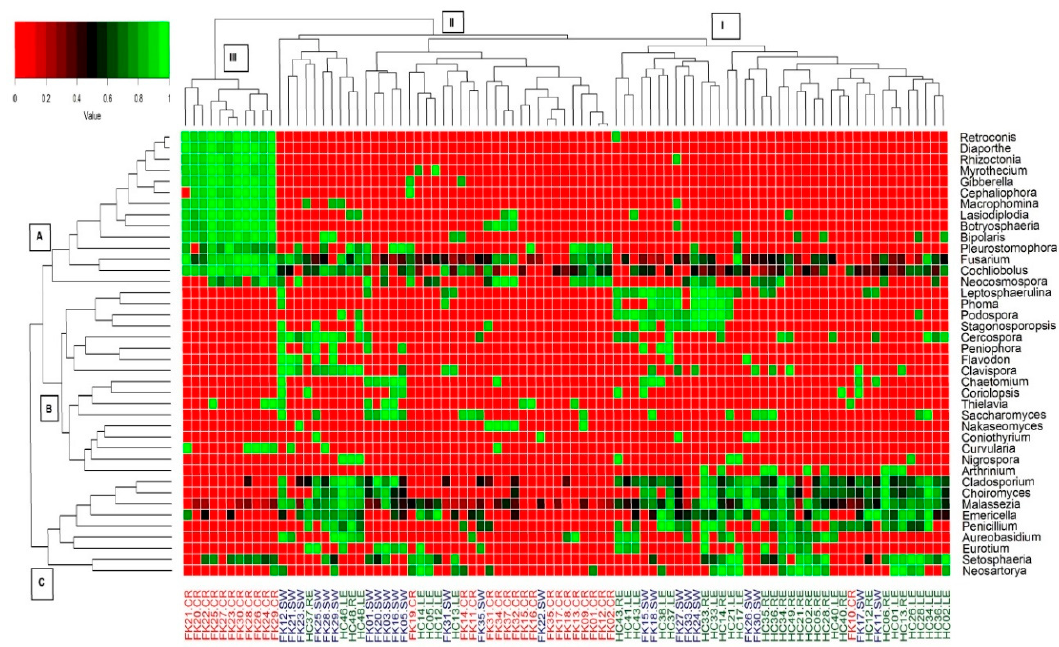
Figure 6. Two dimensional heat map showing rank normalised abundances (scaled between 0 and 1) of 40 differentially abundant fungal genera in the ocular microbiomes of healthy controls conjunctival swabs (HC-SW, n = 37), conjunctival swabs of fungal keratitis patients (FK-SW, n = 23), and corneal scraping of fungal keratitis patients (FK-CR, n = 29). Differentially abundant genera having a median abundance of > 0.0001% in at least one group of samples have been depicted. The discriminating genera have been arranged along the two dimensions (axes) based on hierarchical clustering.